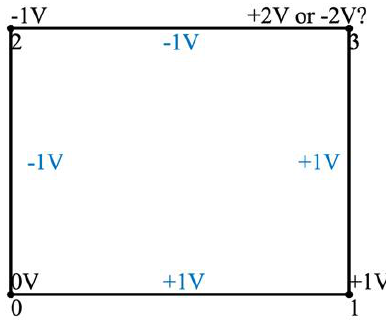
Figure 4. Example of an invalid converter status.